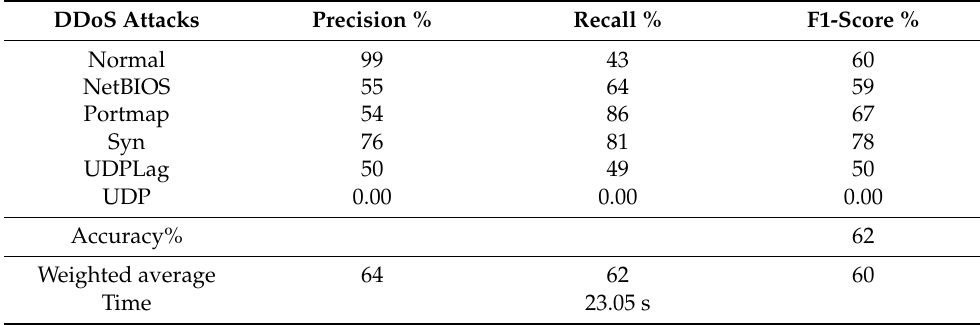
Table 4. Results of LSTM for detecting